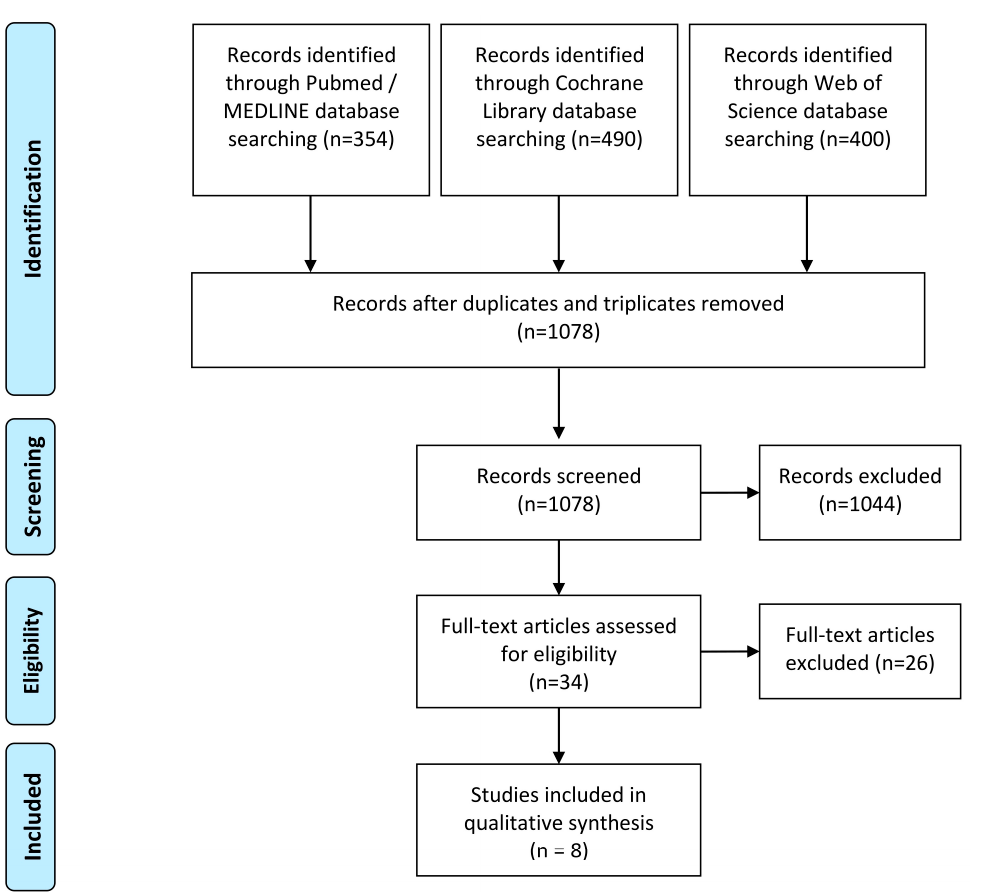
Figure 1. PRISMA flow diagram.